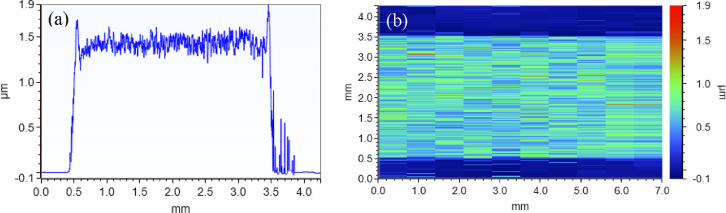
Representative profilometry data is shown. A single 2D profile across the width of a sub-sample's 4-point probe pad is shown in (a). A 3D map of a 4-point probe pad is shown in (b). Here, ten 2D profiles are combined in a top-down view where the height values are shown using the calibrated color scale shown on the right.